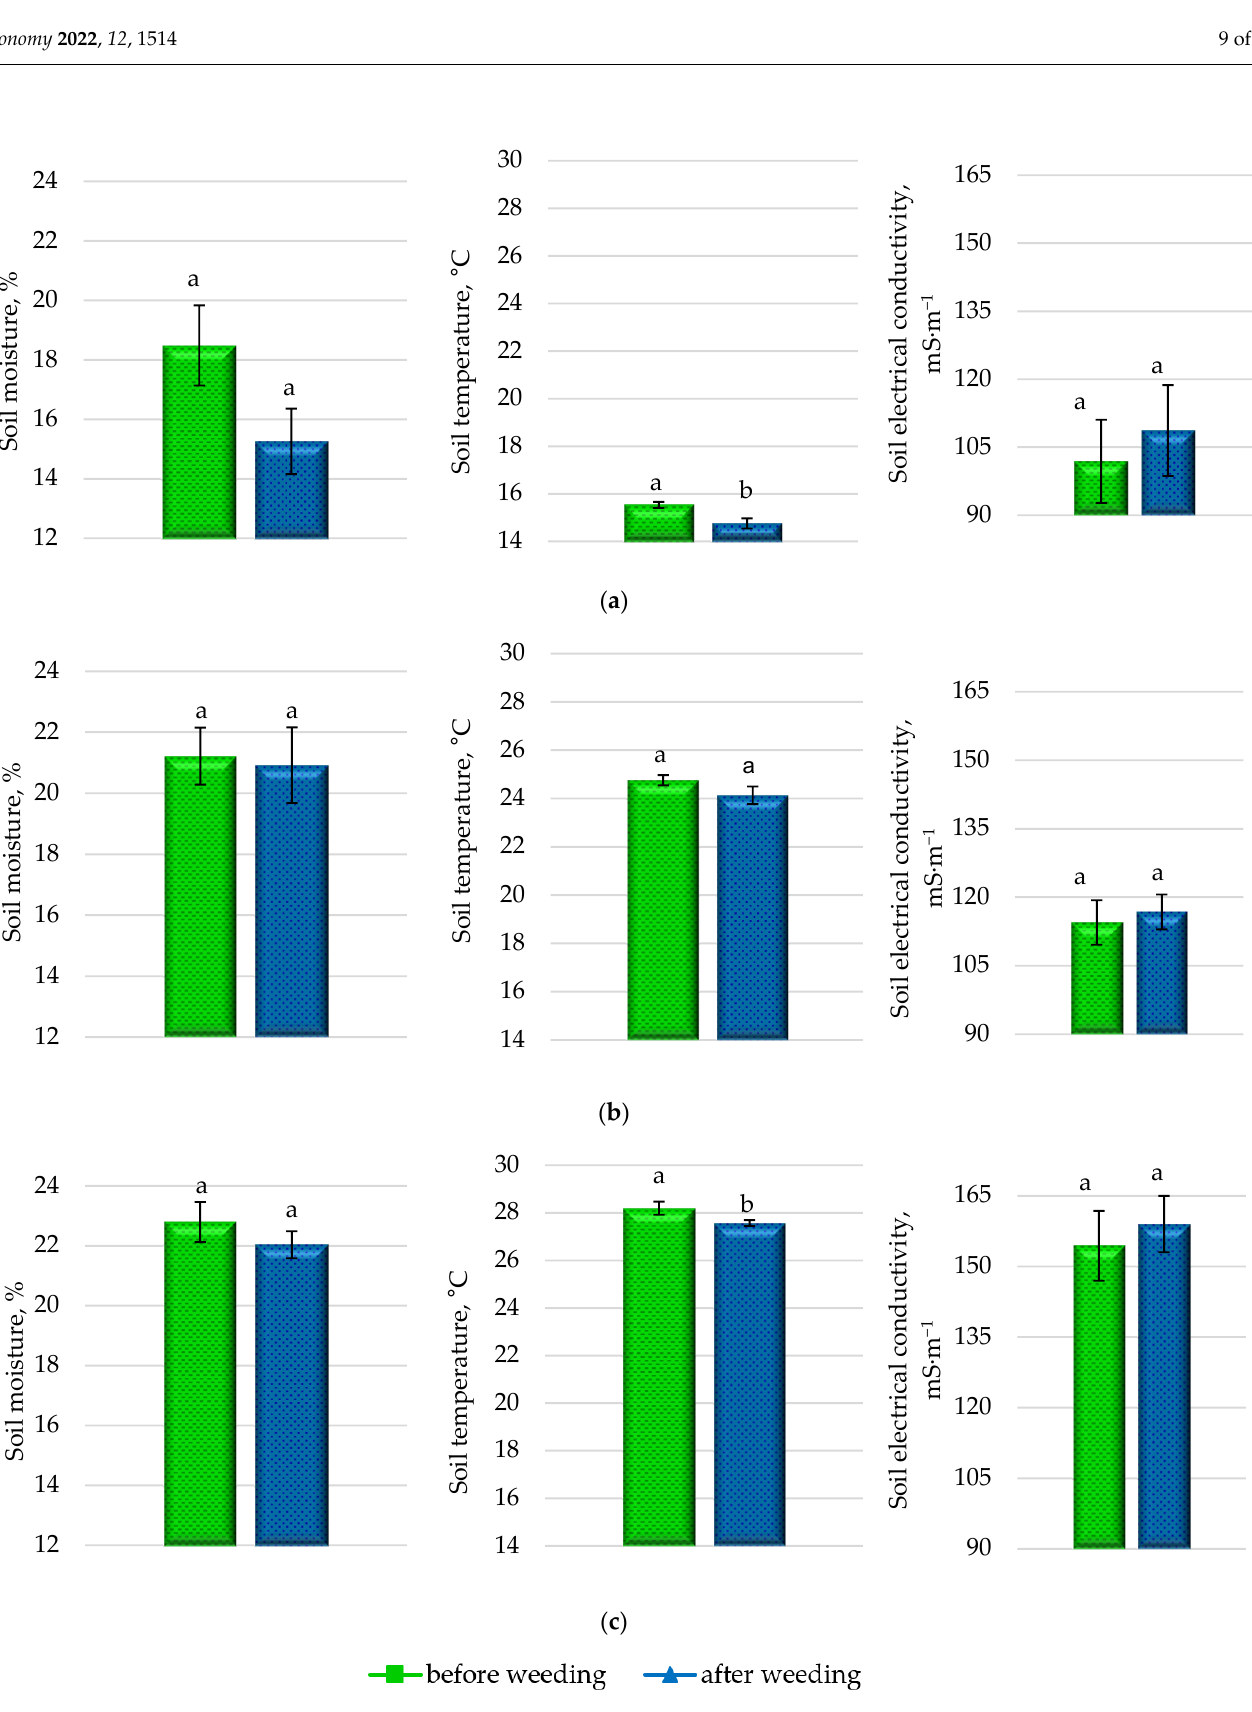
Figure 4. The impact of different weed control systems on soil moisture, temperature, and electrical conductivity: ( a ) CWC1 (25 May 2021); ( b ) CWC2 (4 June 2021); ( c ) RWC (1 July 2021). Different letters a, b in the figures indicate statistically significant